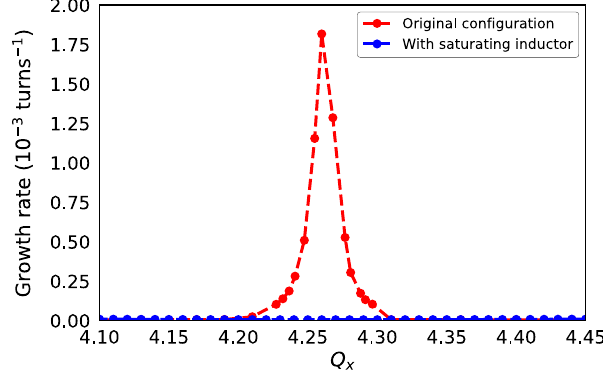
FIG. 19. Instability growth rate at 160 MeVas a function of Q x with the original electrical circuit of the PSB extraction kicker system (red) and the modified circuit with the 25 μ H saturating inductor (blue). The instability is fully suppressed for tunes between 4.10 and 4.45.